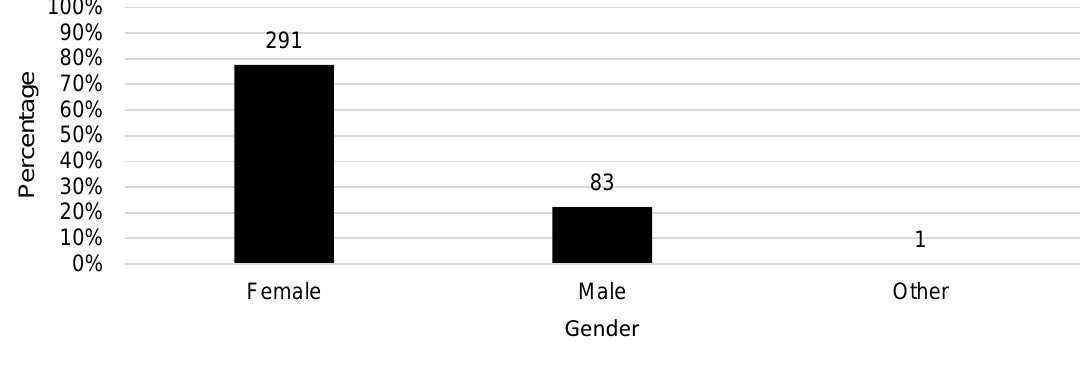
Figure 1 . Gender identification of participatory and deliberative practitioners